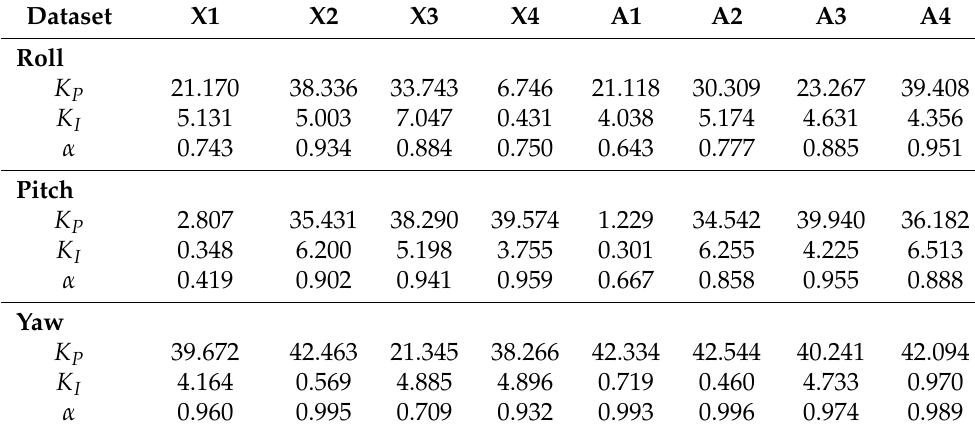
Table 3. Values of LSE-adapted parameters of